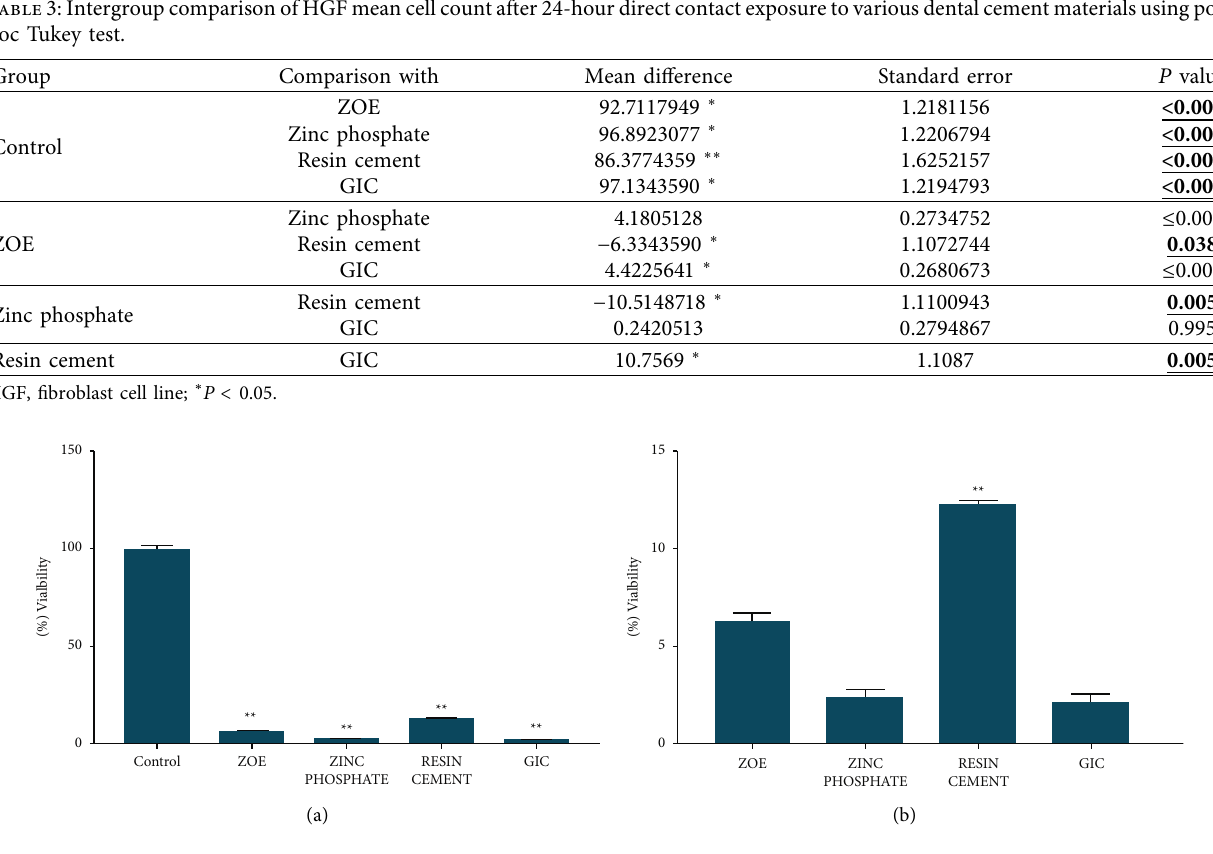
Figure 1: The effect of direct cement exposure on the viability of HGF cells. The cement was prepared and allowed to be set as per the manufacturer’s protocol. The HGF cell viability was tested by MTTassay following 24 hours of exposure. (a) The bar graph represents the HGF viability after 24 hours of exposure along with control cells. (b) The bar graph represents the comparison of HGF viability upon exposure to four dental cements. All the experiments are performed in triplicate and repeated 3 times. ∗ P < 0 . 05 was considered statistically significant.